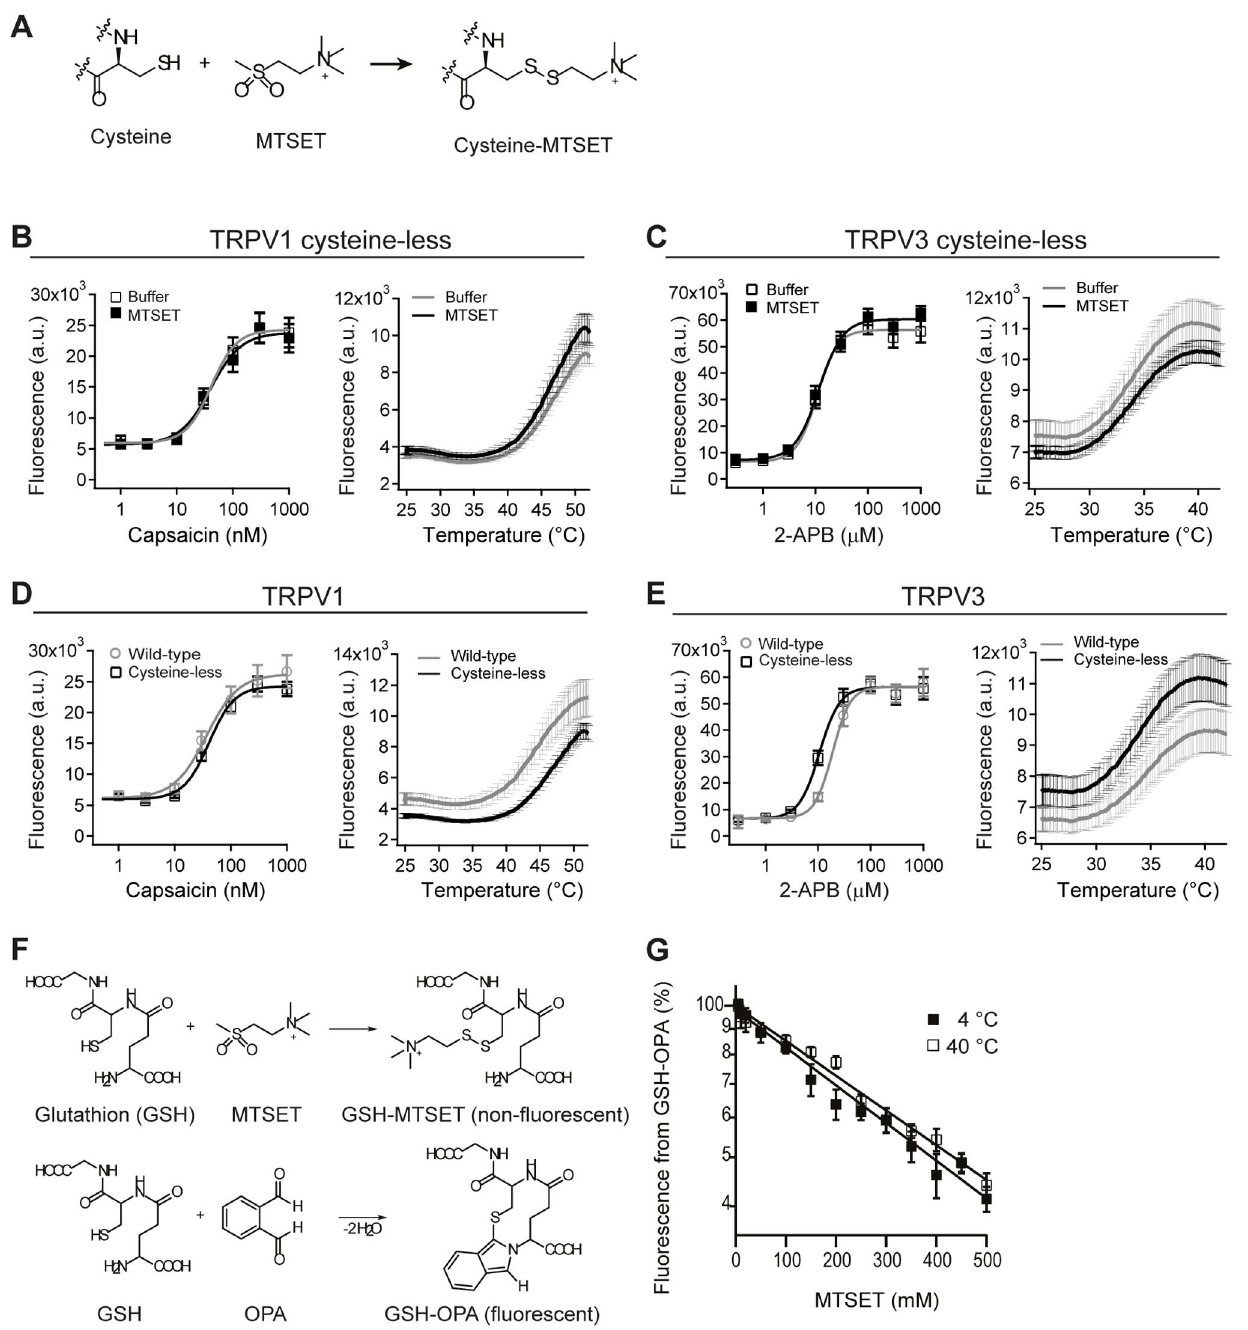
Figure 1. Cysteine scanning on TRPV1 and TRPV3 channels. (A) Schematic of MTSET labeling on a cysteine residue by covalent bond formation. (B–D) Chemical- and temperature- dose-response curves of cysteine-less TRPV1 after application of MTSET or buffer control (B), of cysteine- less TRPV3 after application of MTSET or buffer control (C), of cysteine-less and wild-type TRPV1 (D), and of cysteine-less and wild-type TRPV3 (E). For chemical dose-responses data are averages of five measurements (mean 6 s.d.) and for temperature-responses averages of 16 wells (mean 6 2 6 s.e.). (F) Reaction schemes of GSH with MTSET and GSH with OPA. (G) Fluorescence signal of obtained from competing reactions in (F) as a function of MTSET concentration at 4 u C and 40 u C. n . 20 with from three independent experiments. Error bars are mean 6